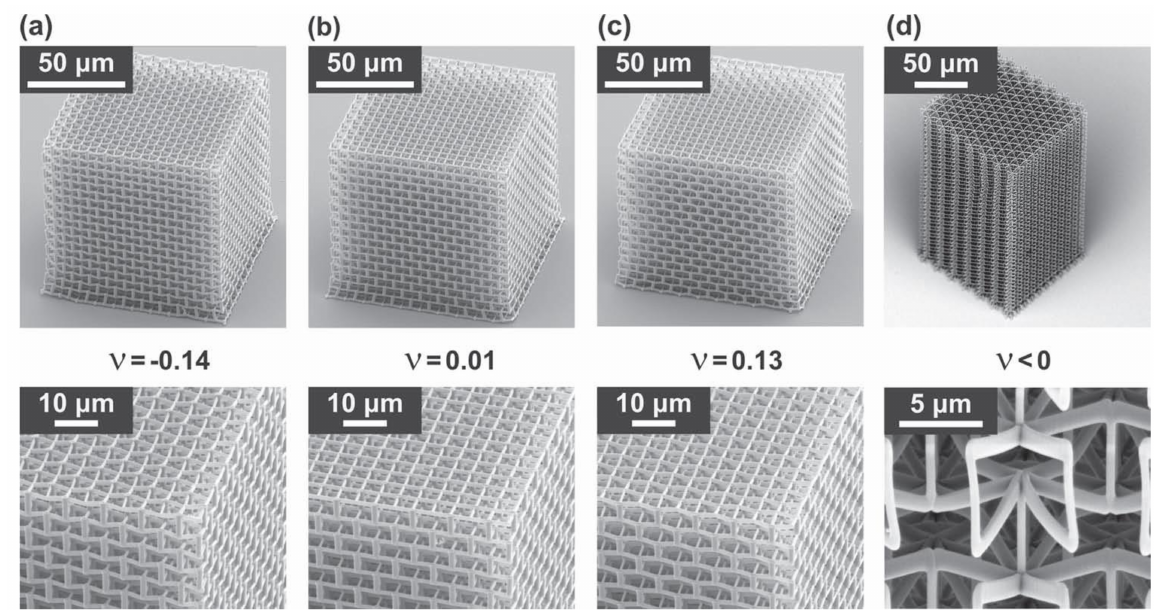
Figure 5. Fabrication results of the 3D meta-materials with auxetic unit cells. ( a – c ): 3D auxetic structure with a four-fold axis, ( d ): 3D auxetic structure with a six-fold axis. (A figure was reproduced with permission from John Wiley and Sons